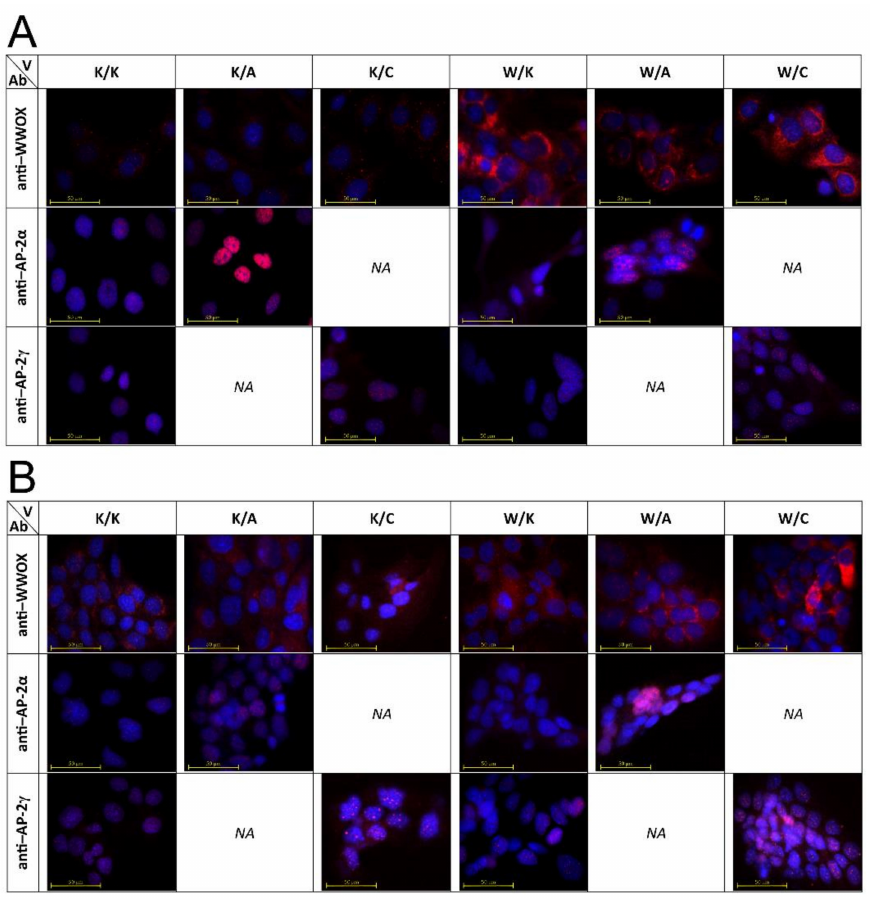
Figure 3. Cellular location of WWOX, AP-2 α and AP-2 γ within in vitro variants. ( A ) HT-1376 cells. ( B ) CAL-29 cells. V—Variant.